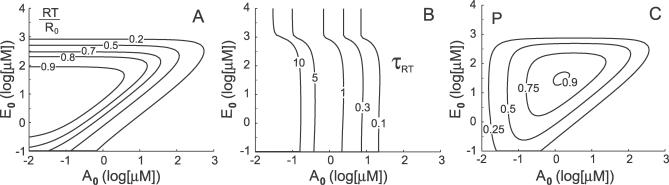
The GTPase Activity and the Overall Cycling Performance Are Improved by the Introduction of a GEF-Activating GTPase Effector SThe profiles of the GTPase activity (A), recovery time (B), and performance index (C) are plotted as contour lines. Note the increase in the area of the optimal control and its shift toward lower GEF concentrations in comparison with Figure 3C.